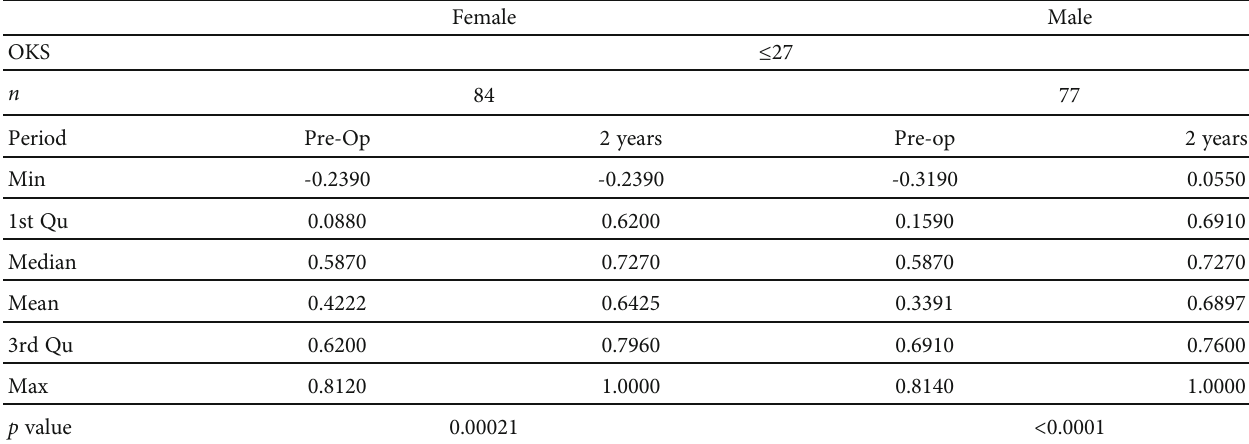
Table 4: EQ-5D score at preoperative baseline and at two years ’ follow-up for all patients with OKS ≤ 27 at